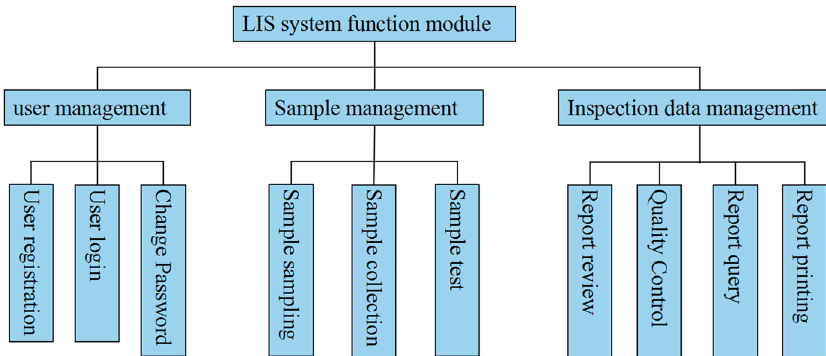
Figure 1: Functional module division of the LIS